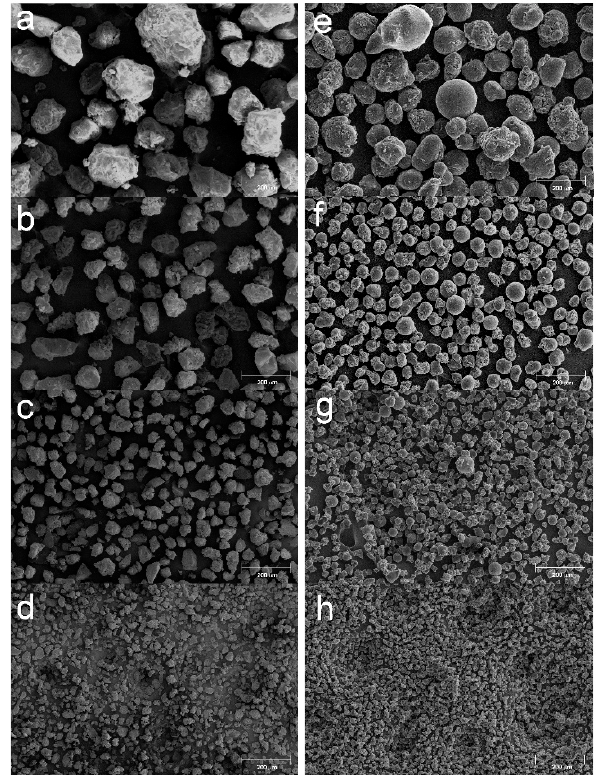
Figure 1. SEM micrographs of β -cyclodextrin nanosponge. ( a ) ( β NS) > 100 µ m, ( b ) β NS 71–100 µ m, ( c ) β NS 40–71 µ m, ( d ) β NS < 40 µ m, ( e ) C- β NS > 100 µ m, ( f ) C- β NS 71–100 µ m, ( g ) C- β NS 40–71 µ m, ( h ) C- β NS < 40 µ m. Magnification: 100 ×.